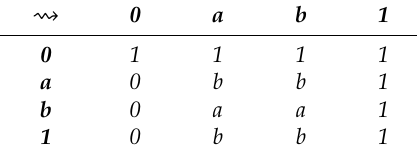
Table 13. The operation (cid:32) on X